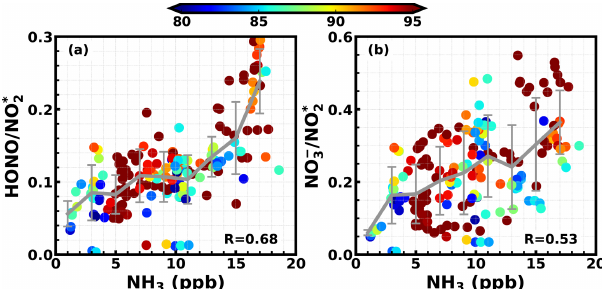
Figure 8. The relationship between the NH 3 concentration and the (a) HONO / NO ∗ ratio and (b) the NH 3 concentration and the ni- 2 / NO ∗ trate/nitrogen dioxide ratio (NO − ). Colors of scatter points 3 2 represent ambient RH values, and the color bar is shown on top of the